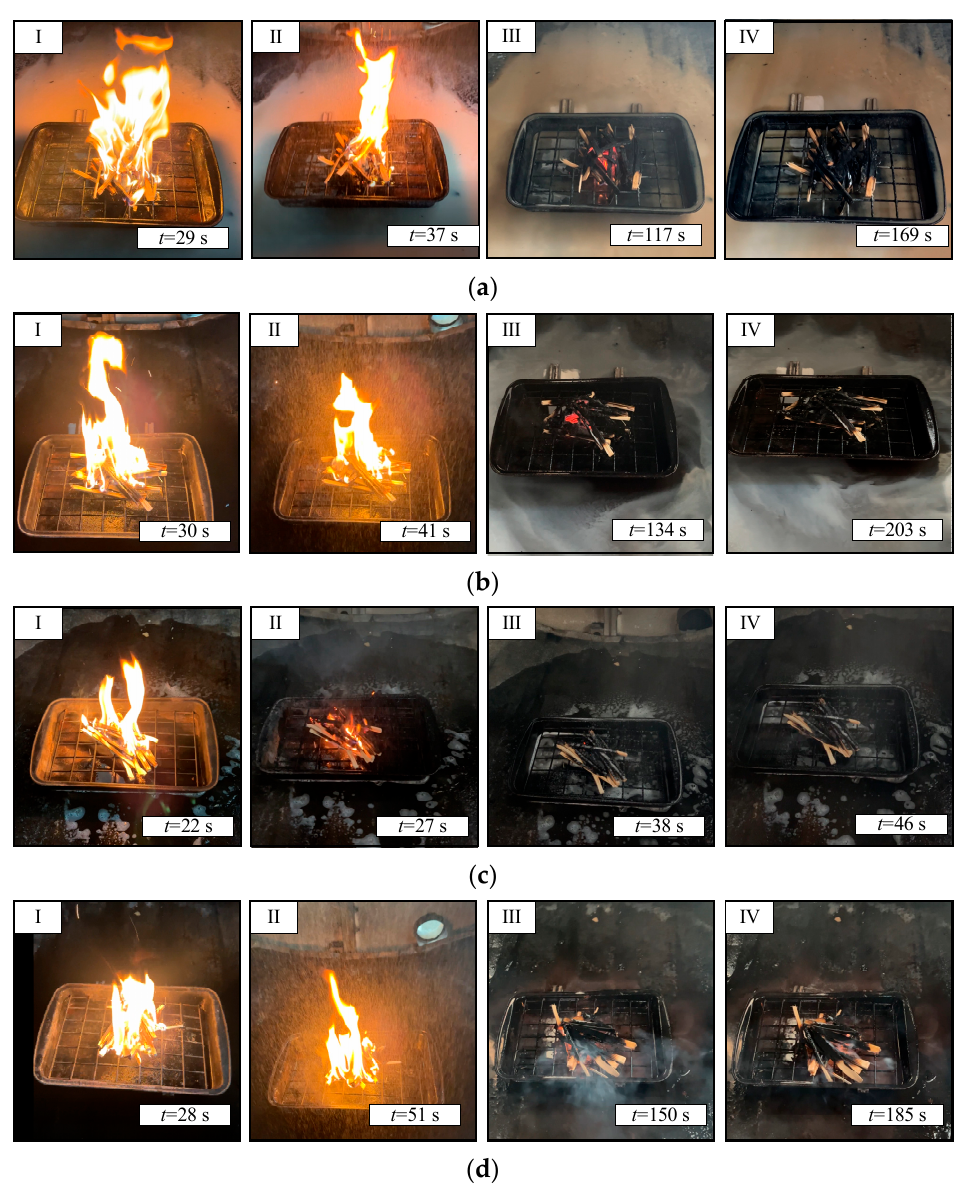
Figure 4. Images of laboratory-scale fires under investigation at different combustion and suppression stages: I—active combustion; II—suppression; III—smoldering; and IV—completion of combustion product release: ( a ) — bentonite; ( b )—bischo fi te; ( c )—foaming agent; and ( d )—water. Figure 5a,b and Supplementary Materials Videos S1 and S2 present the trends and average concentrations of CO and CO 2 , produced in the continuous and cycling modes of extinguishing laboratory-scale fi res with timber using water. The CO concentration growth corresponds to the time when a sprayed water fl ow was applied to the fi re. The carbon monoxide and dioxide concentrations peaked at 249 s.